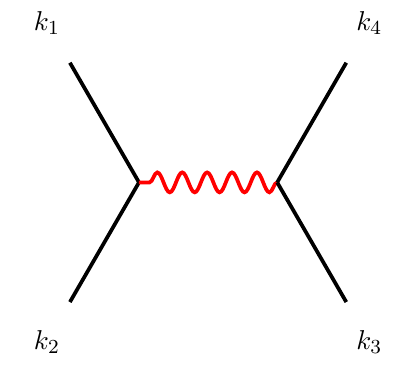
Figure 2 . Conventions for Feynman diagrams.